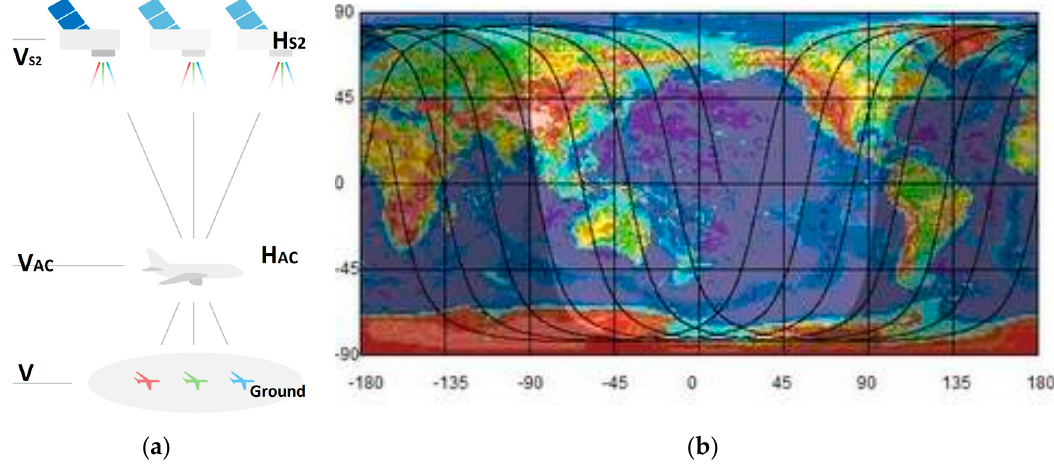
Figure 3. ( a ) Illustration of the satellite-aircraft-ground parallax effect. ( b ) Earth map with projected satellite orbits. The orbits cross the vertical lines (latitudes φ ) at angles θ S 2